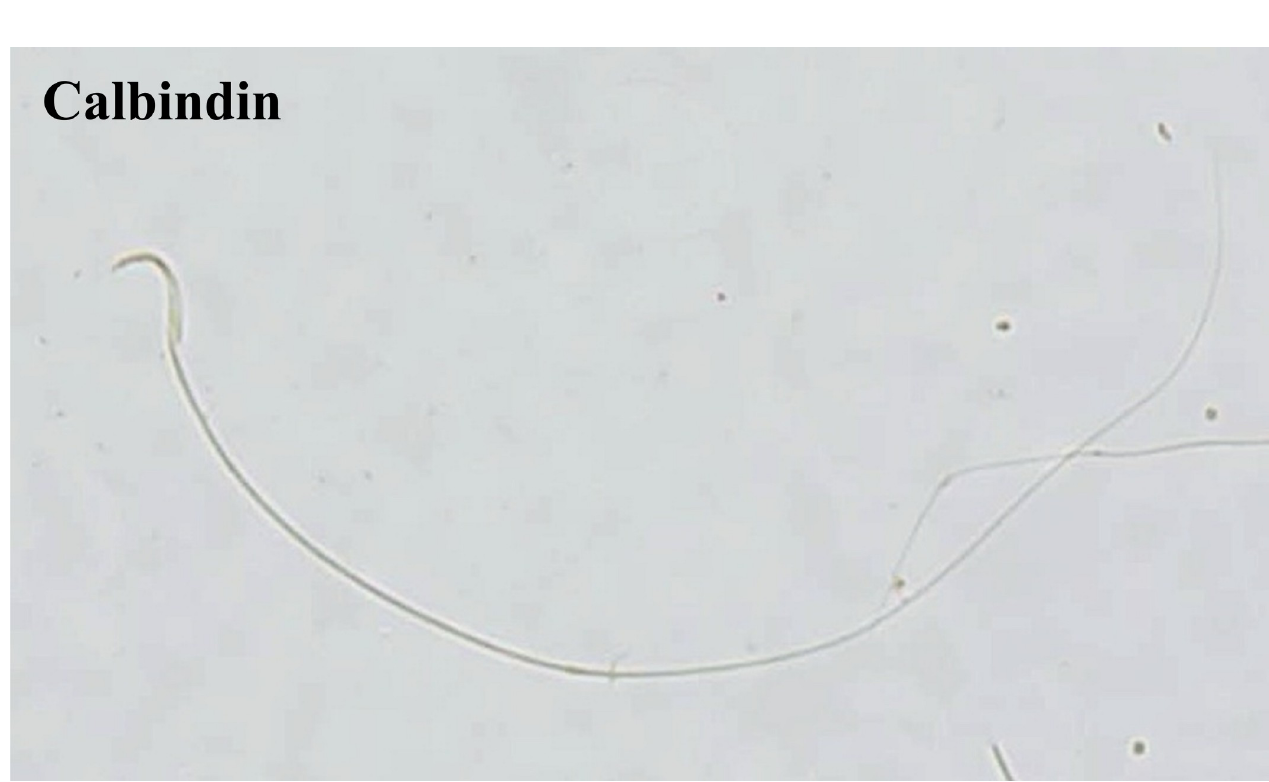
Fig 7. Positive immunostaining for calbindin in rat epididymal spermatozoa at 200 × magnification.